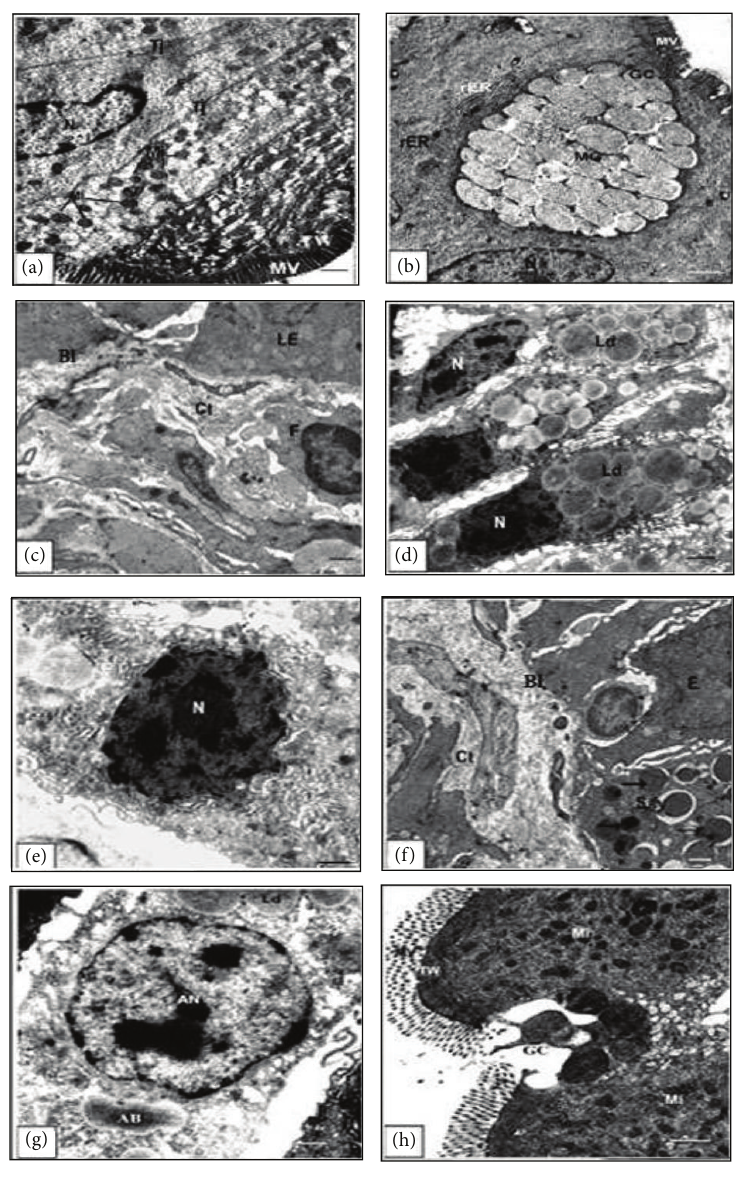
Figure 2: Electron micrographs of the anterior portion of the small intestine of the prometamorphic stage 55 ((a)–(c)) and the metamorphic stage 60 ((d)–(h)) showing the following (a): apical cytoplasm with a well-developed microvilli (MV), numerous mitochondria (Mi), terminal web (TW) and tight junction (Tj). (b): the apical surface of the epithelium containing large goblet cell (GC) with mucus granules (MG). (c): epithelial-connective tissue interface showing the thin basal lamina (BL) under the larval epithelial (LE) cells. (d): a columnar epithelium with numerous lipid droplets (Ld). (e): intestinal epithelial cell with irregular nuclear envelop and chromatin condensation. (f): epithelial-connective tissue interface showing apoptotic bodies (arrows) in the larval epithelium. (g): apoptotic nucleus (AN) with chromatin condensation and irregular nuclear envelop. (h): discharging GC at the apical region. Scale bar = 1 𝜇 m.